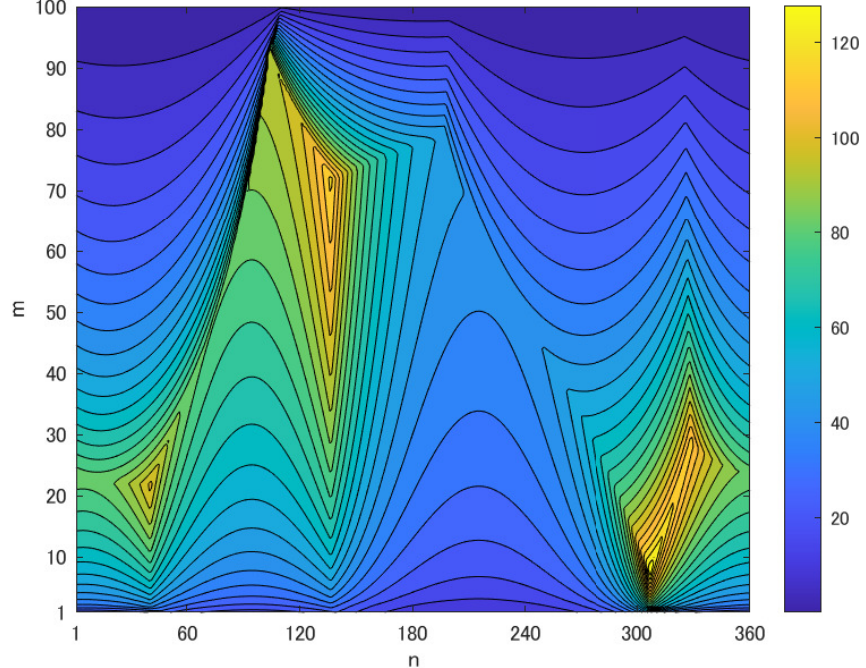
Figure 3. Lookup table plotted with contour lines. n , hue; m ,